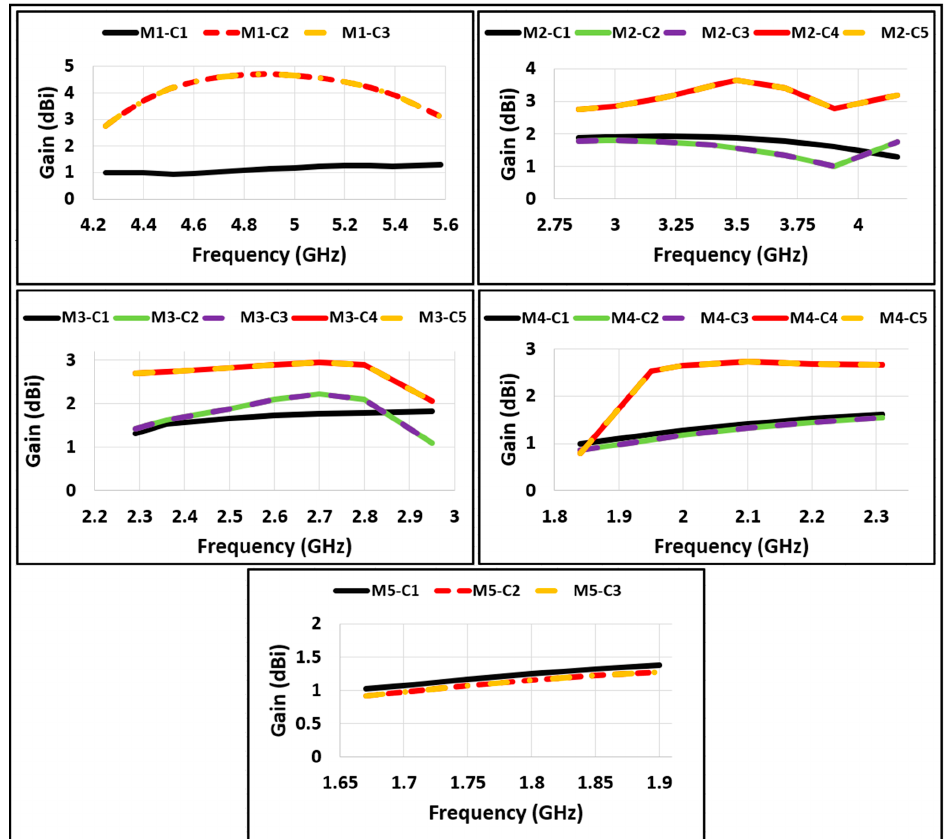
Figure 10. Gain vs frequency plots for all Modes and Cases of Operation. Figure 10. Gain vs. frequency plots for all Modes and Cases of